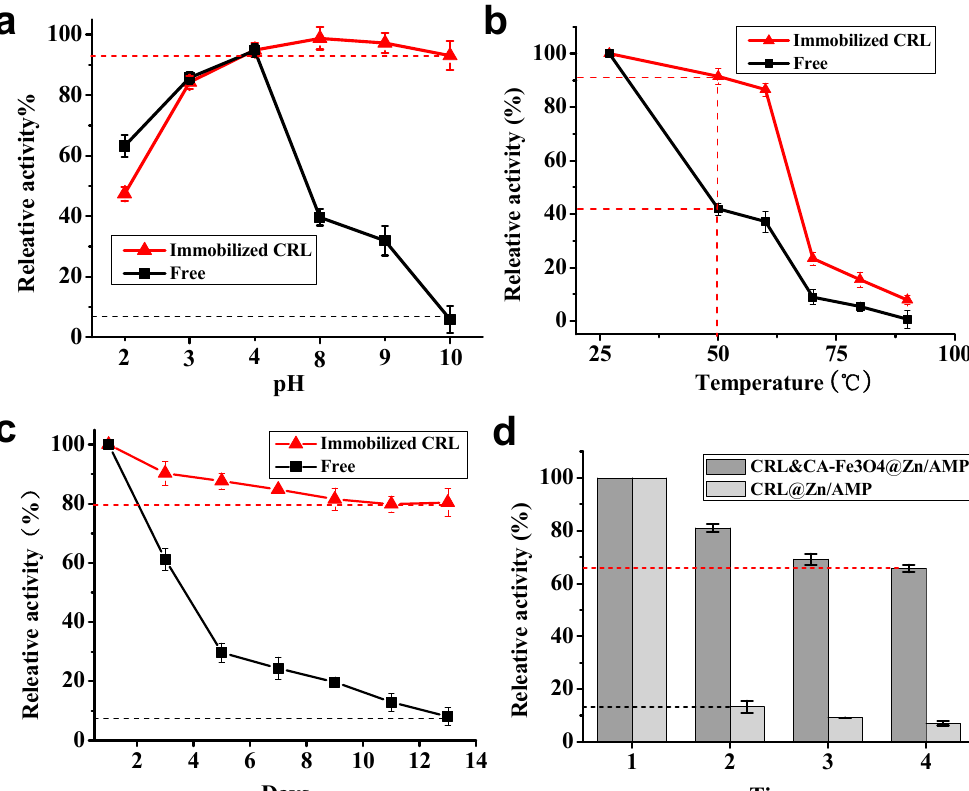
Figure 5. Comparison of pH ( a ), thermal ( b ), and long-term ( c ) stability of CRL&CA-Fe 3 O 4 @Zn/AMP nanofibers with equivalent free enzymes; ( d ) the recycling performance of immobilized enzymes with or without Fe 3 O 4 NPs.